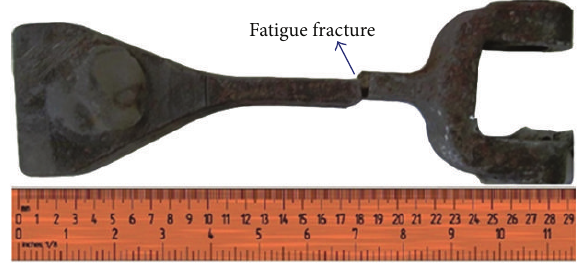
Figure 3: Hammer fatigue fracture location.